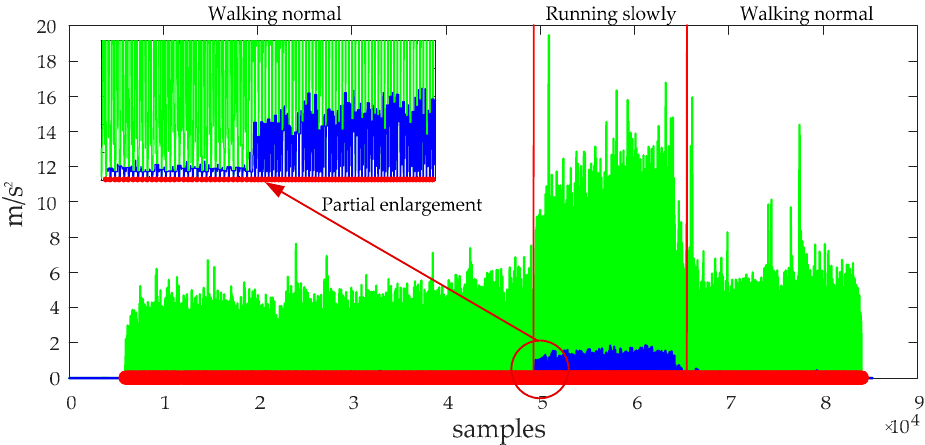
Figure 15. The result of the still-phase detection using adaptive still-phase detection with 517 steps detected. The green lines denote the standard deviation of acceleration and the red dots denote the detected